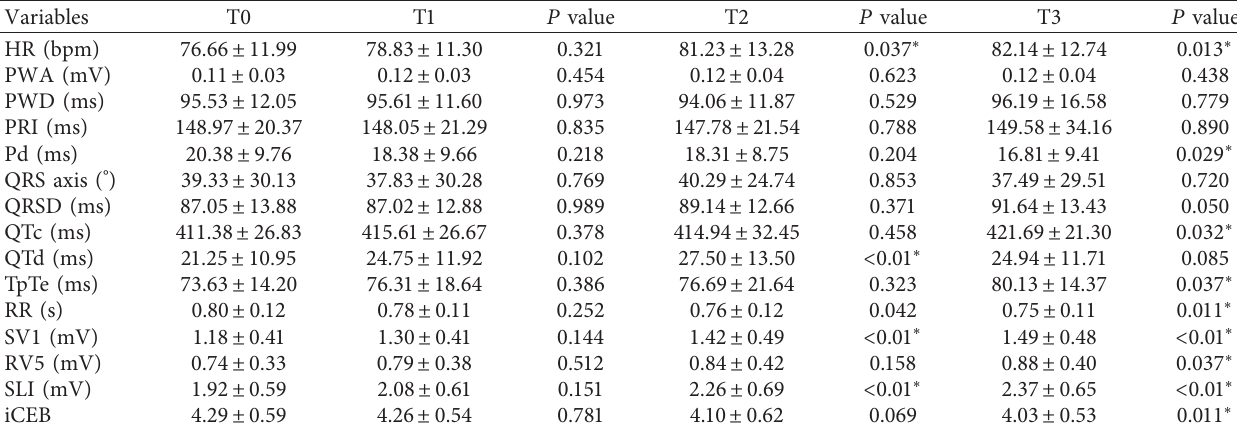
Table 4: Electrocardiographic parameters before and at each follow-up point during chemotherapy in BC patients. Variables